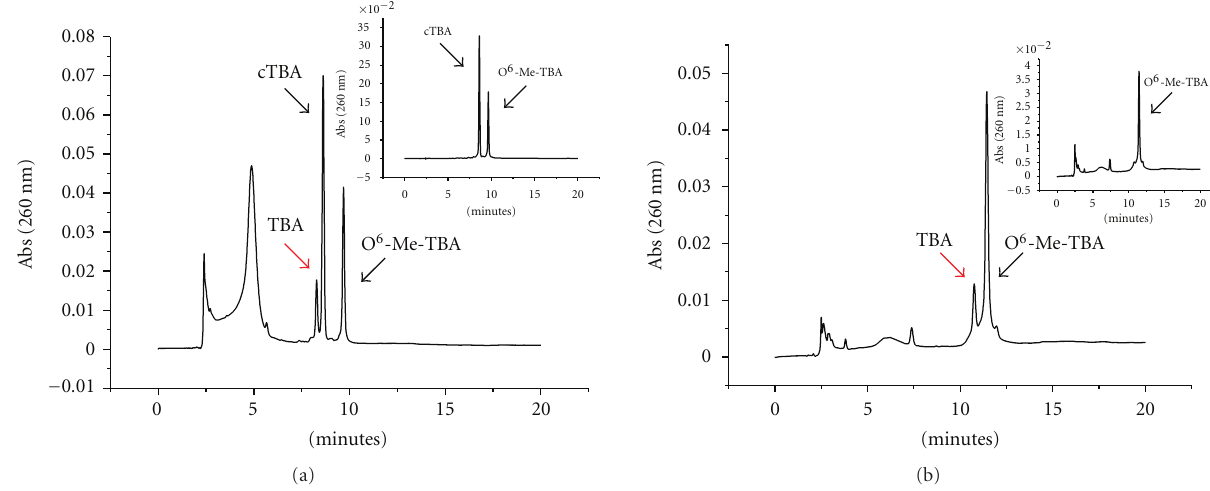
Figure 4: HPLC analysis of hAGT activity over double- and single-stranded TBA before and after incubation with hAGT. (a) Repair of double-stranded 5-O 6 -MeG-TBA by hAGT. The peak labelled as cTBA corresponds to the complementary sequence of 5-O 6 -MeG-TBA. The top right panel shows HPLC chromatogram in absence of hAGT. The gradient was from 10%–40% acetonitrile for 20 min at 60 ◦ C. (b) Repair of single- stranded 5-O 6 -MeG-TBA by hAGT. The inserted panel shows HPLC chromatogram in the absence of hAGT. Gradient used: 10%–40% acetonitrile, 20 min at room temperature.